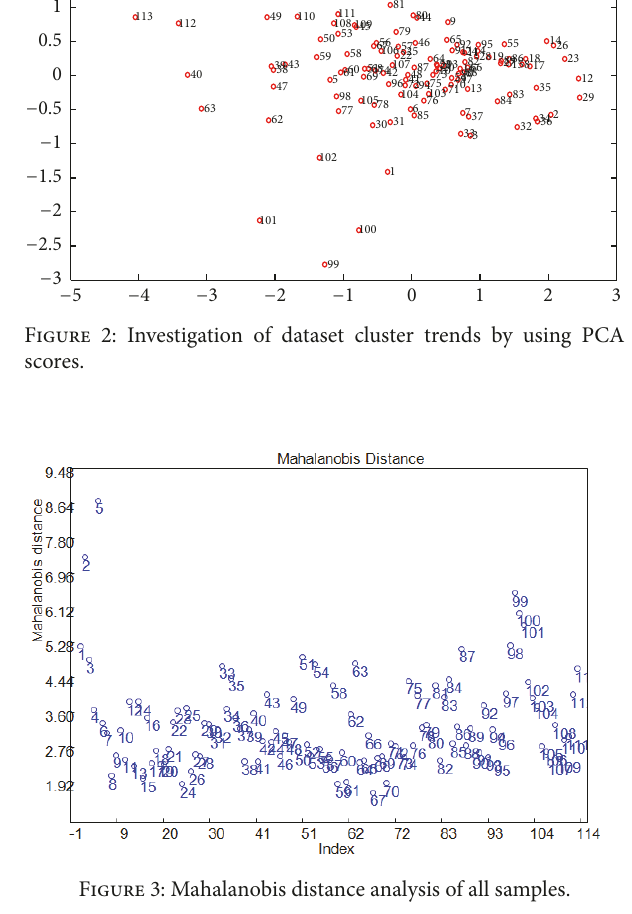
Figure 3: Mahalanobis distance analysis of all samples.